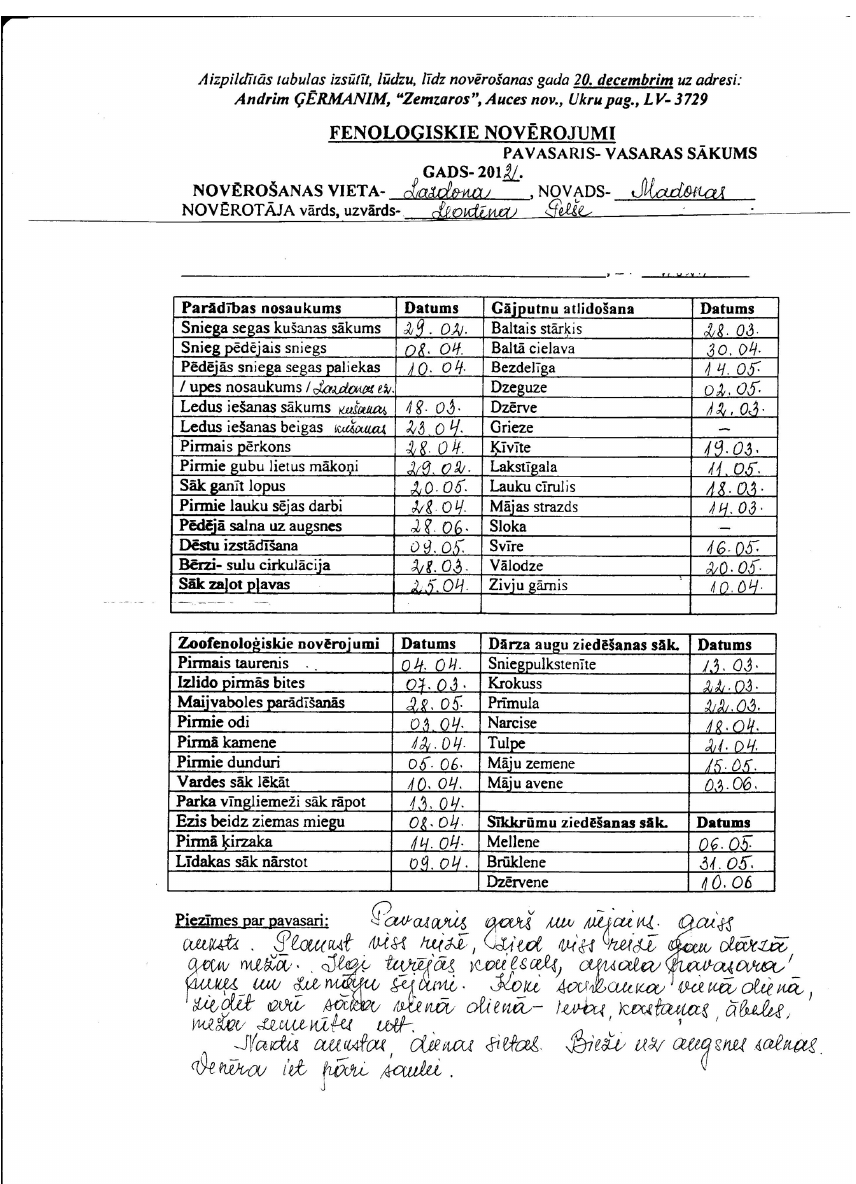
Figure 2. Excerpt from the notes made by voluntary observer Leont¯ına Pelše in Lazdona, in autumn of